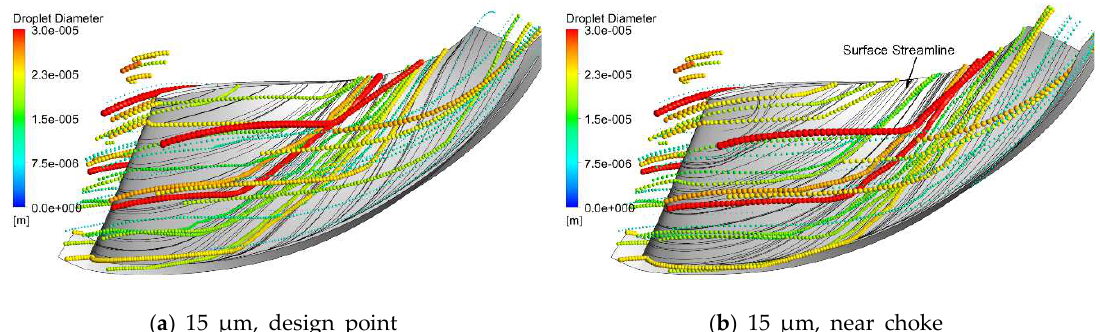
Figure 19. Surface streamline and droplet trajectories near the pressure side